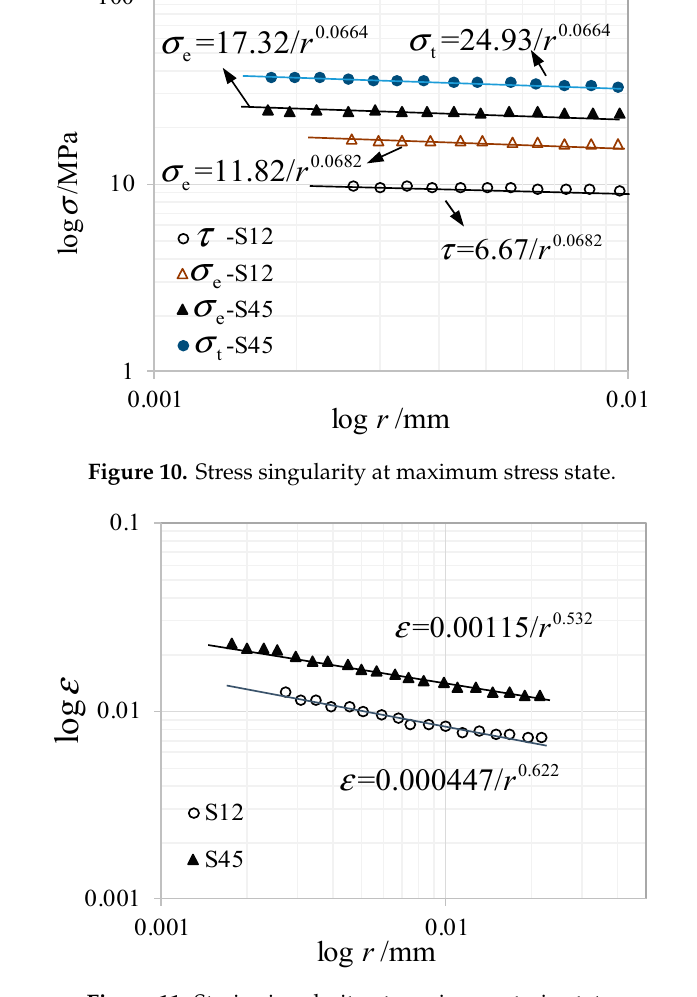
Figure 11. Strain singularity at maximum strain state. Table 2. Analysis results of maximum strain fields.